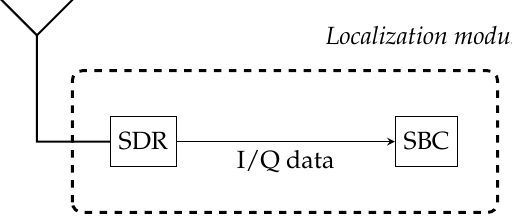
Figure 11. Onboard localization module: a software-defined radio provides I/Q samples to a single board computer.